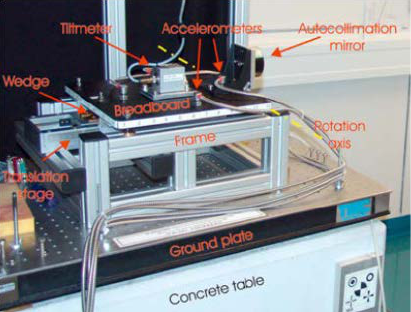
Figure 9. Kinematic test facility with attached tiltmeter and accelerometers. (Source: Woschitz and Macheiner,